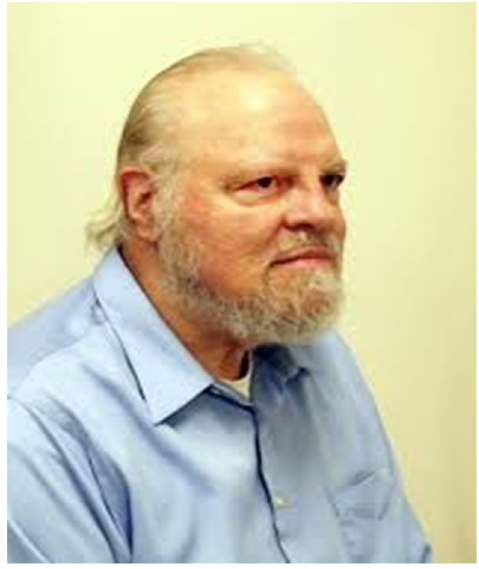
Figure 1. Dr. James D. McChesney.